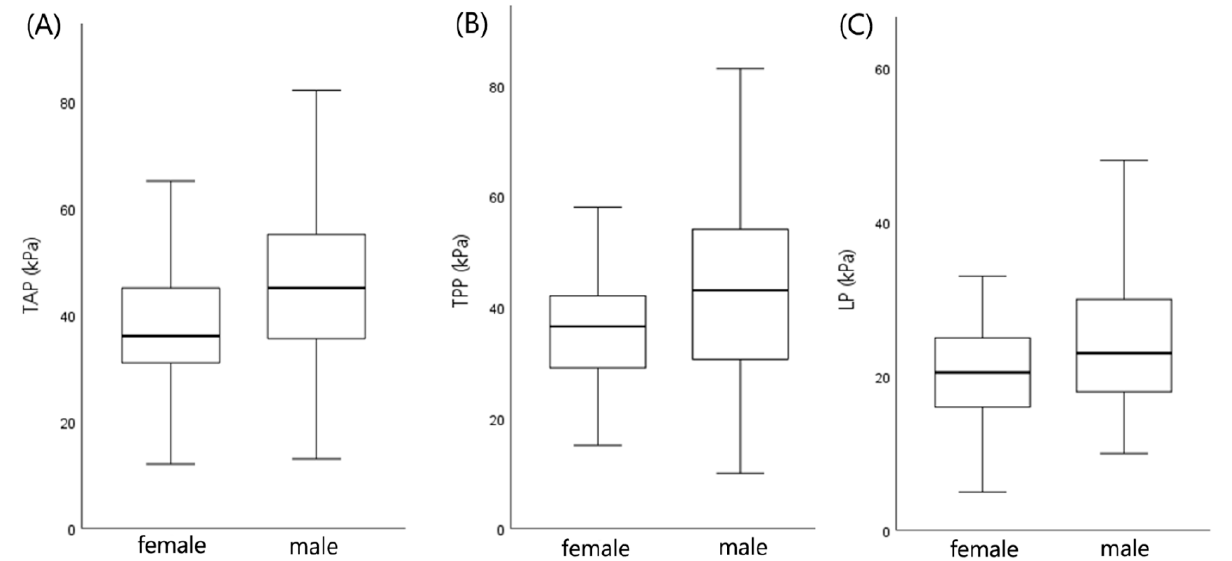
Figure 4. Sex-based pressure differences; ( A ) TAP, anterior tongue pressure. ( B ) TPP, posterior tongue pressure. ( C ) LP, lip pressure.